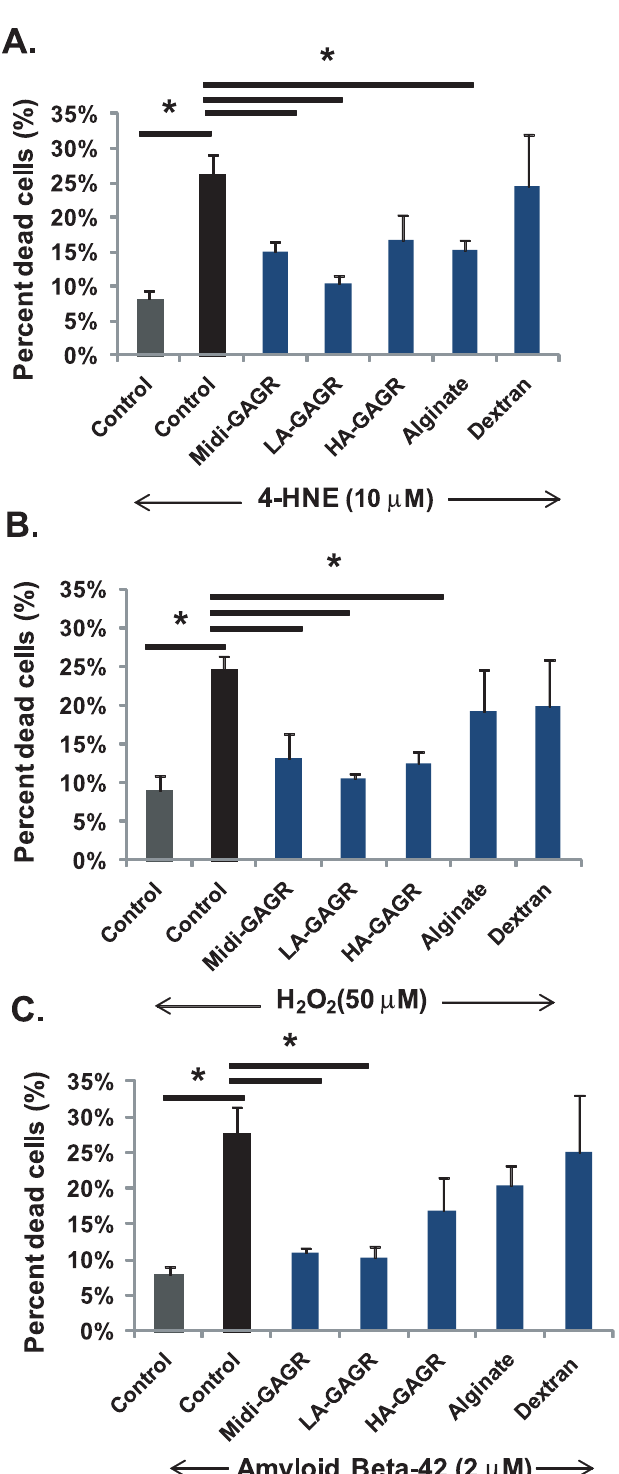
Fig 4. Quantification of neuron death in response to oxidative insults in the presence of different polysaccharides. The numbers of live and dead cells were counted using Metamorph software. Bar graphs represent the percents of dead neurons after the pre-treatments with different polysaccharides followed by treatment with 4HNE (A), H 2 O 2 (B), or A β 42 (C). Data represent mean ± SEM of three independent experiments. For each experiment, at least, 1,000 cells per group were counted. * , p <